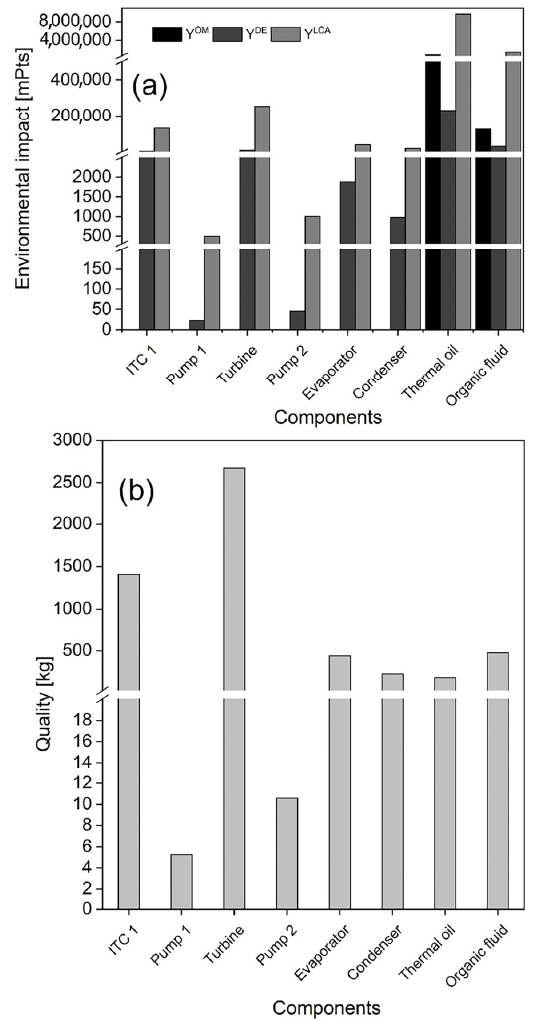
Figure 9. Life cycle analysis results for steel for ( a ) Environmental impact and, ( b ) Quality. A comparison between the values found in Section 3.1, and the environmental im- pacts associated with product exergy, fuel, and loss, infers that there is little relationship between them. For example, in the case of the ITC1, which was the component with the highest irreversibility, it was found that it only has the highest environmental impact in terms of exergy of losses caused by the high temperature of the exhaust gases at the outlet of the same component. Generally speaking, the component with one of the greatest en- vironmental impacts is the condenser, being the component with the greatest environ- mental impact associated with the concept of fuel and destroyed exergy. In other words, in those components in which heat is exchanged, the environmental impacts per unit of exergy are greater, unlike the turbine and pump, which are the least contaminating com- ponents. For the conditions previously analyzed, it is possible to know in which of all the com- ponents there are greater opportunities for improvement in terms of the reduction of the environmental impacts generated by evaluating the parameter 𝑟 (cid:3029),(cid:3038) . For the case of study, it is observed that pump-1 and the condenser are the components that have a higher en- vironmental ratio with 579.15% and 116.78%, respectively, showing that their